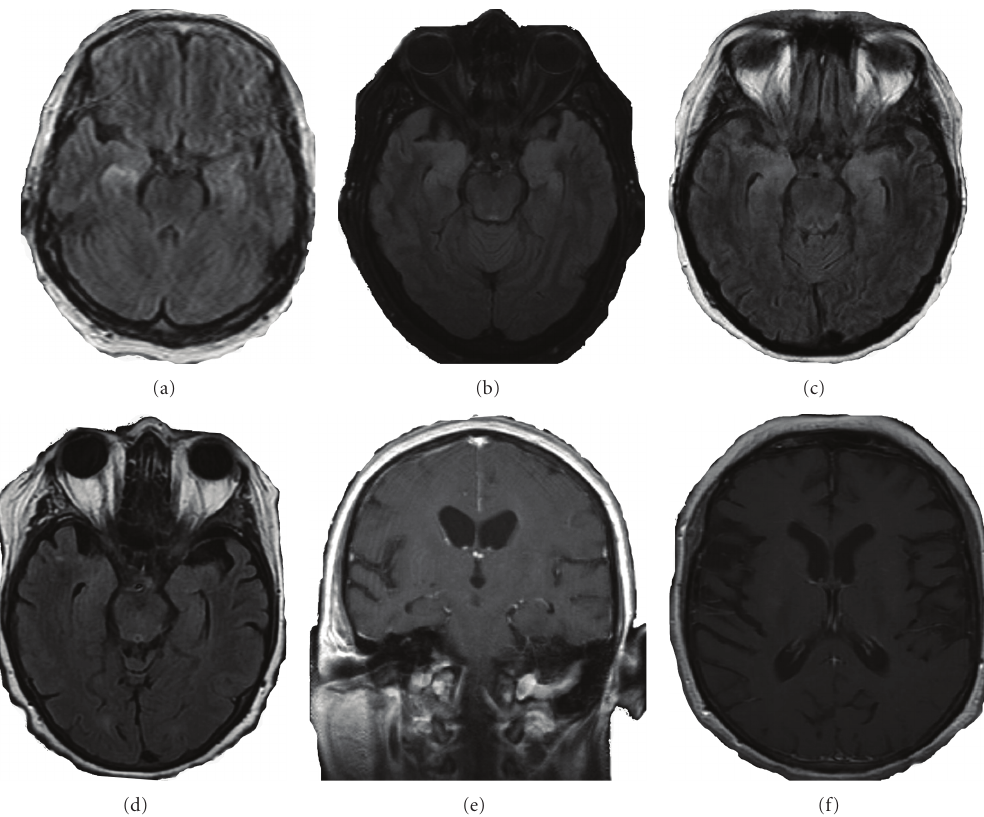
Figure 1: MRI findings in two cases of immunotherapy responsive autoimmune subacute encephalitis. Brain MRI of Patient 1 ((a), (b)) with immunotherapy responsive voltage-gated potassium channel antibody and antithyroperoxidase antibody-associated subacute encephalitis illustrates increased signal in the bilateral medial temporal lobes on T2 fluid attenuated inversion recovery (T2 FLAIR) sequences ((a) initial image). Follow up image after 8 months (b) was unchanged. Brain MRI of case 2 illustrates increased signal in the bilateral medial temporal lobes on T2 FLAIR ((c) initial image) and after 13 months (d) shows its resolution; T1 with contrast sequence ((e) initial image) shows bilateral temporal atrophy and after 13 months (f) showing persistent bilateral frontotemporal